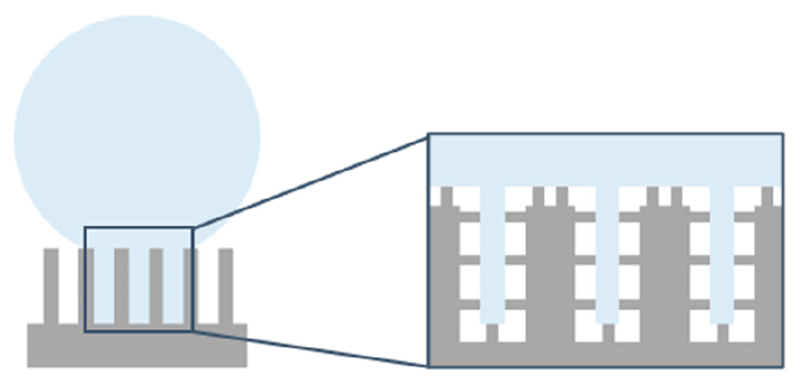
Figure 14. Rose petal configuration in samples textured with micrometric square pillars with nano- metric roughness.